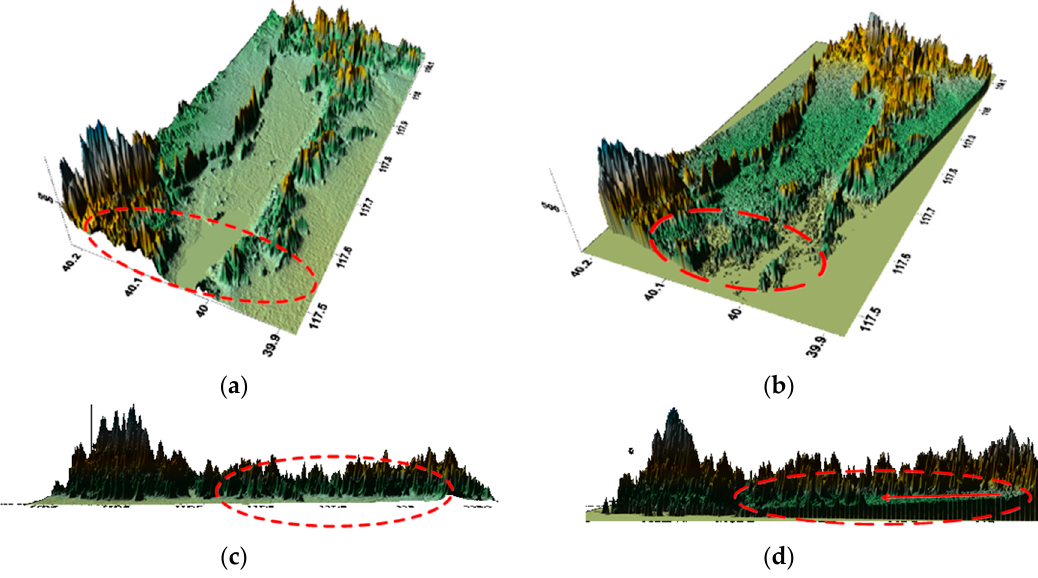
Figure 11. DEM product after correcting ∆ B (cid:107) : ( a ) SRTM DEM along the latitude; ( b ) GF-3 generated DEM along the latitude; ( c ) SRTM DEM along the longitude; ( d ) GF-3 generated DEM along the